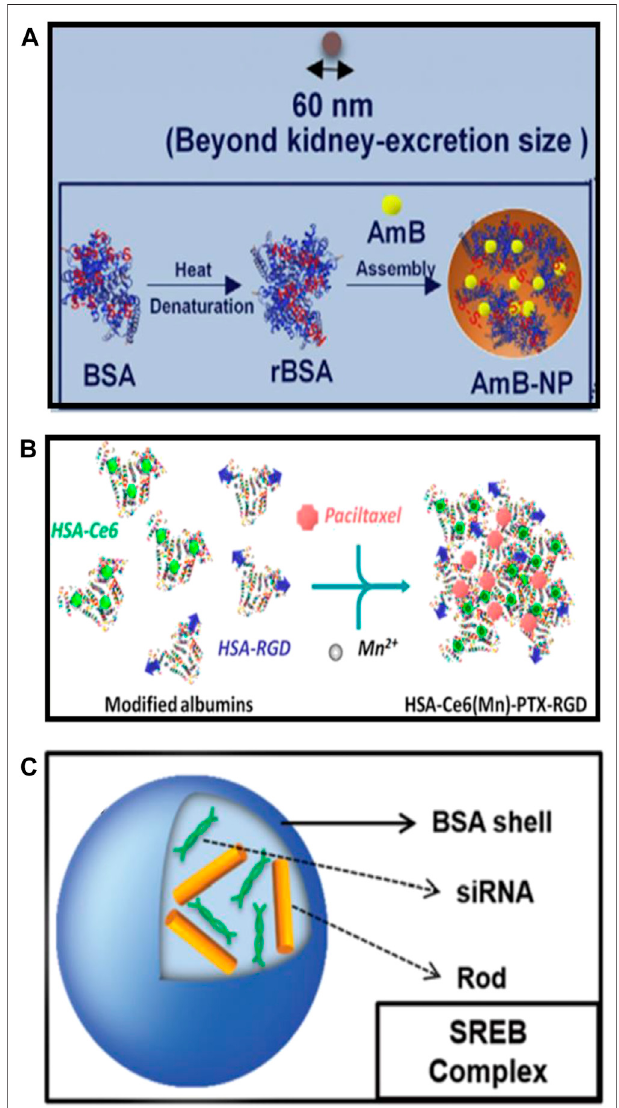
FIGURE 2 | The schematic illustrations of the typical representatives of (A) albumin nanoparticles [reproduced with permission from Liu X. et